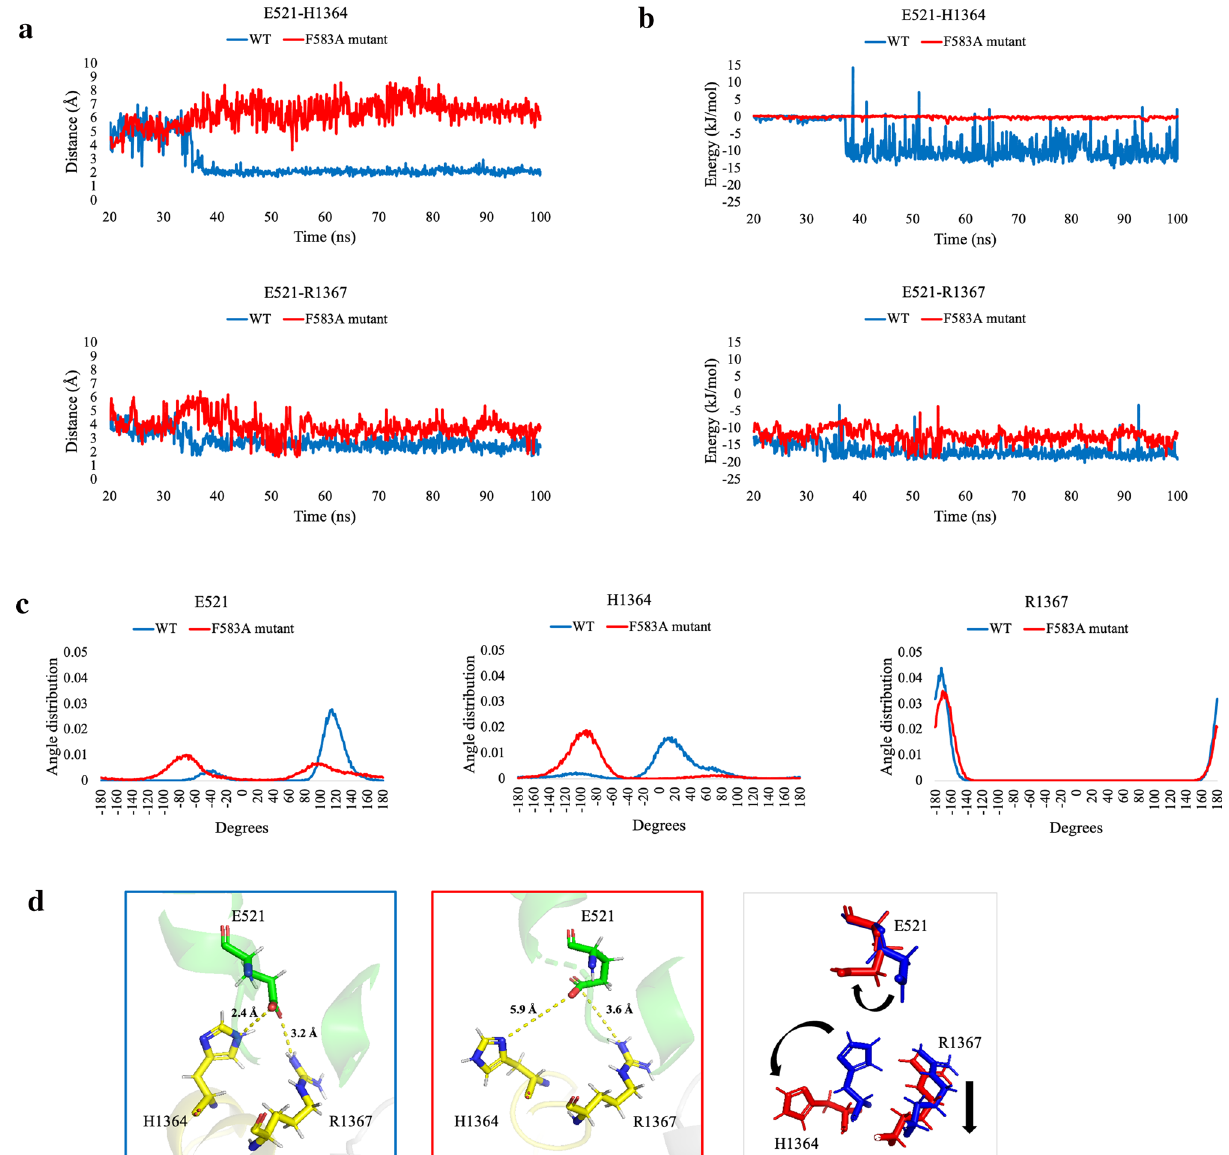
Figure 8. The interaction between helix 10 (E521) and NBD2 through the s5/h2 element (H1364 and R1367). (a) Dynamic distance analysis comparison of the distances between E521-H1364 and E521-R1367 between the WT and the F583A mutant. (b) Total energy (vdW + Electrostatic) calculations for E521-H1364 and E521-R1367. (c) Dihedrals’ analysis comparison of E521, H1364, and R1367 between the WT and F583A mutant. E521 and H1364 showed significant difference in the distribution of the dihedral angle (p-value = .00374 and .00001, respectively) while R1367 showed no difference (p-value = .4413). (d) Comparison of the distances of H1364-E521 and R1367-E521 (H1364 and R1367 from s5/h2 loop and E521 from helix 10) between the main conformation of the WT (blue) and the main conformation of the F583A mutant (red). The right figure presenting the shift between the WT’s residues to the mutant residues, by black